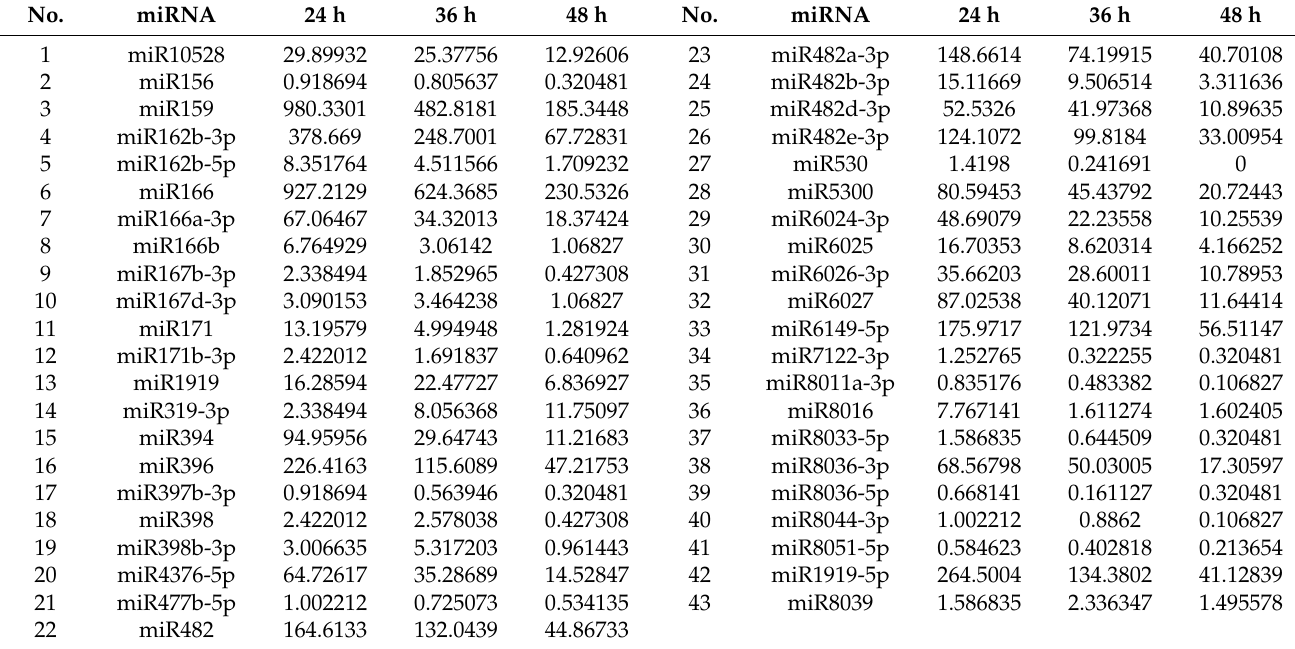
Table 1. Predicted potato miRNAs that are already annotated in miRbase during potato- P. infestans